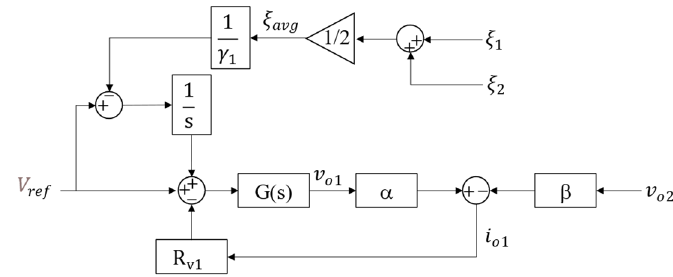
Figure 4. Hierarchical control diagram.